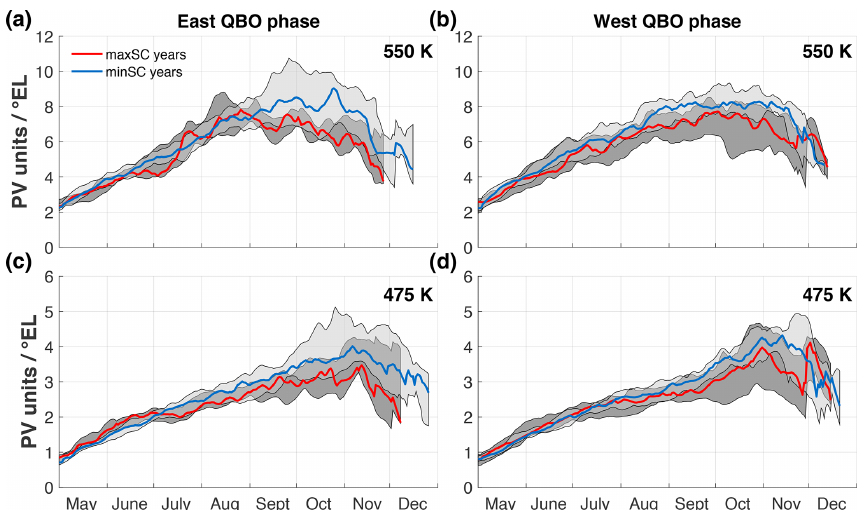
Figure 5. Composites of the seasonal evolution of vortex edge intensity according to SC and QBO for the period 1979–2020, from (a) to (d) : 550 and 475K. Panels (a) and (c) represent eQBO phases and panels (b) and (d) represent wQBO phases (Sect. 2.2). Red curves represent median values for maxSC years and blue curves for minSC years. Dark gray areas indicate values between the 20th and 80th percentiles for maxSC years and light gray areas for minSC years.